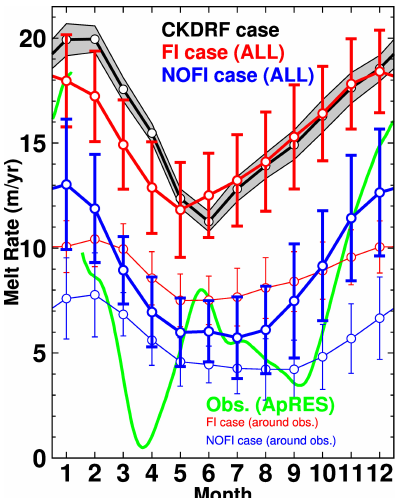
Figure 7. Seasonal variation in basal melt rate at the Shirase Glacier tongue. Black, blue, red, and green lines show results from the CK- DRF, NOFI, and FI cases and the ice-radar-derived estimate (au- tonomous phase-sensitive radio echo sounder – ApRES; Hirano et al., 2020), respectively. Thick lines represent the mean melt rate av- eraged over the whole of the SGT. Thin red and blue lines show the regional basal melt rate around the ApRES observation (see Fig. 8 for the locations). Shade or vertical bars indicate the standard devi- ation of the monthly basal melt rate in the period 2008–2018, show- ing the model’s inherent variability and interannual variability. The scale of the vertical axis is the equivalent annual melt rate (myr − 1